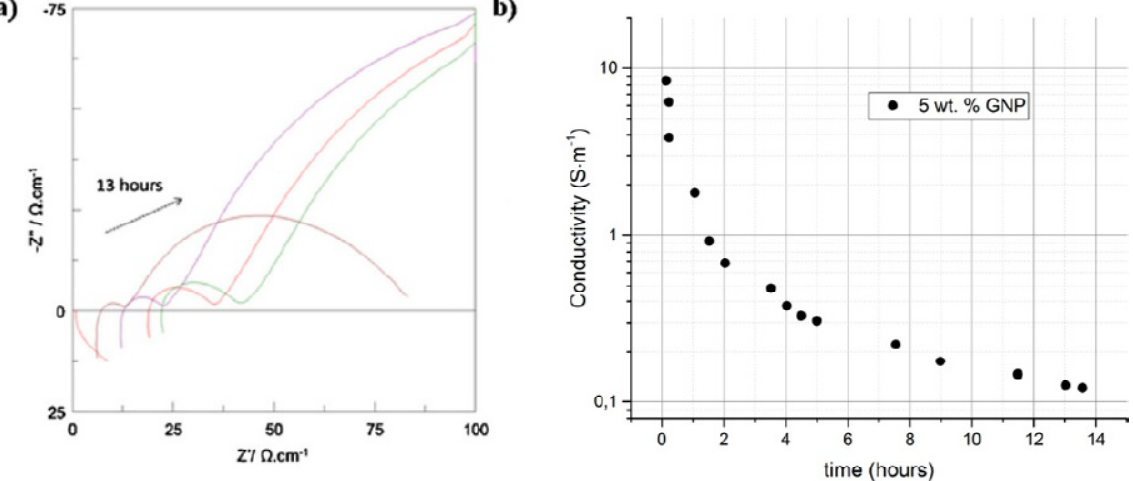
Fig. 9. The effect of YSZ-GNP (5.0 wt.% GNPs) thermal exposure (500 ° C, 13 hours) on (a) electrochemical impedance spectra, (b) electric conductivity, data from